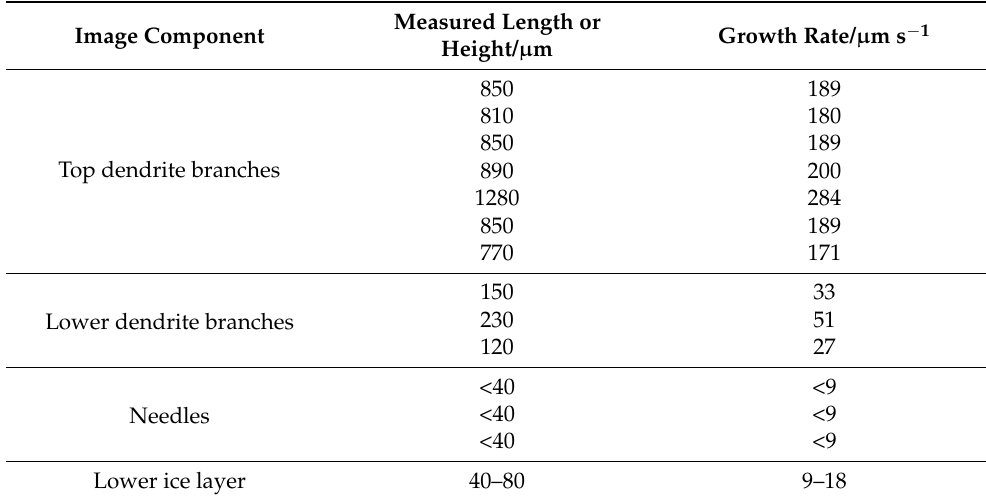
Table 2. Measured length or height of green sections of image components in Figure 6c. The time difference between frames b and a is 4.5 s.